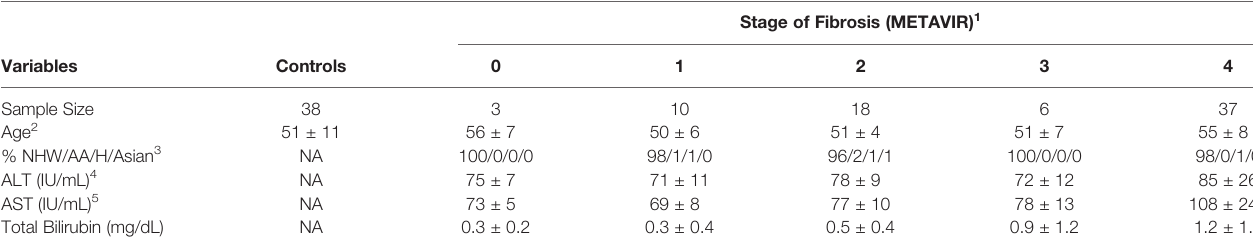
TABLE 1 | Description of control patients and those with liver fi